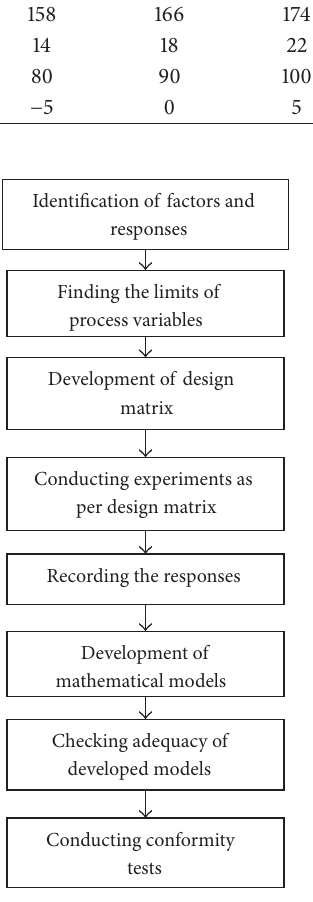
Figure 3: Experimental design